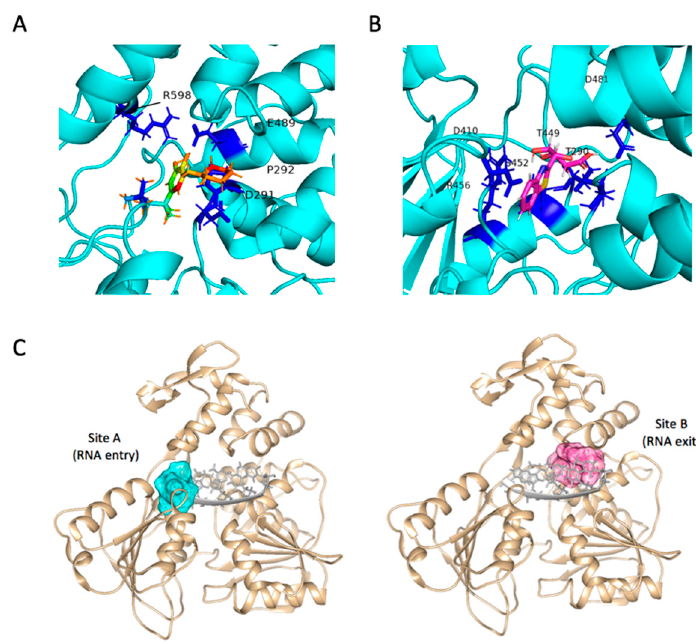
Figure 6. ( A ) Predicted binding modes of Compound 1 (shown in green with color by atom type) inside ZIKV NS3Hel pocket with crucial interacting residues (shown in blue). ( B ) Predicted binding modes of Compound 2 (shown in magenta with color by atom type) inside ZIKV NS3Hel pocket with crucial interacting residues (shown in blue). ( C ) Molecular demonstration of target site A and site B (shown in cyan and pink, respectively) generated according to predicted interacting residues and relative locations to ssRNA (shown in gray) inside ZIKV NS3Hel (shown in tan), corresponding to RNA entry and exit path.